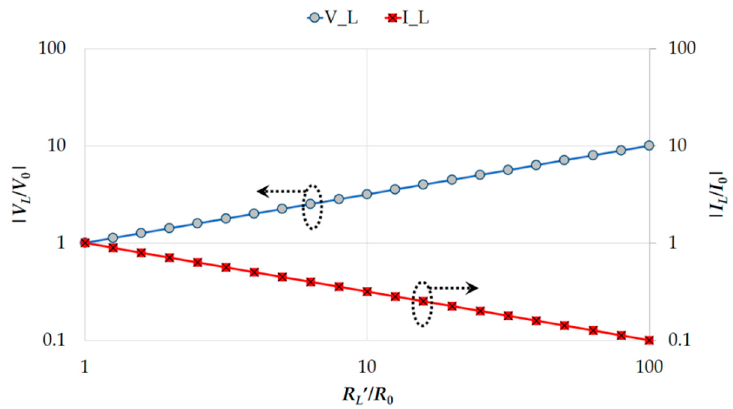
Figure 7. Voltage and current behaviors under various impedance values.